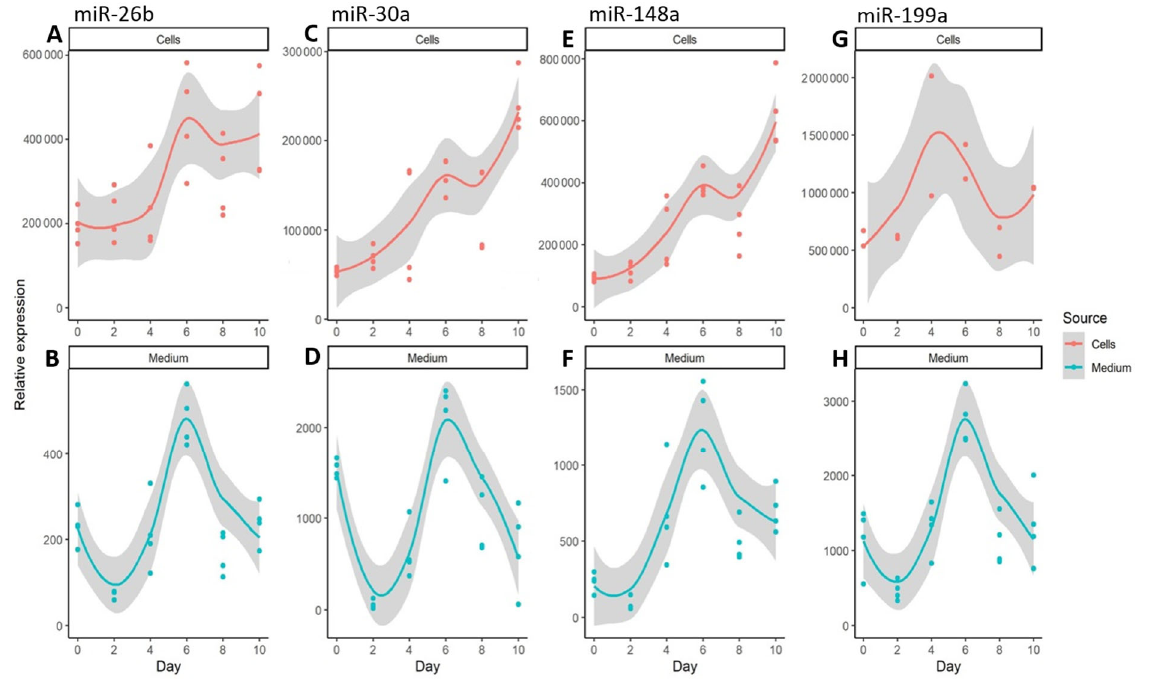
Figure 5. Relative expression levels of extracellular and intracellular miRNAs related to adipogenesis during the ten days of adipocyte differentiation. The expression of miR ‐ 26b ( A , B ), miR ‐ 30a ( C , D ), miR ‐ 199a ( E , F ), miR ‐ 148a ( G , H ) was normalized using RNU6B. Dots represent the actual measurements, the line is a local regression based on the collected data points, and the gray area represents the 0.95 confidence interval for the regression line.